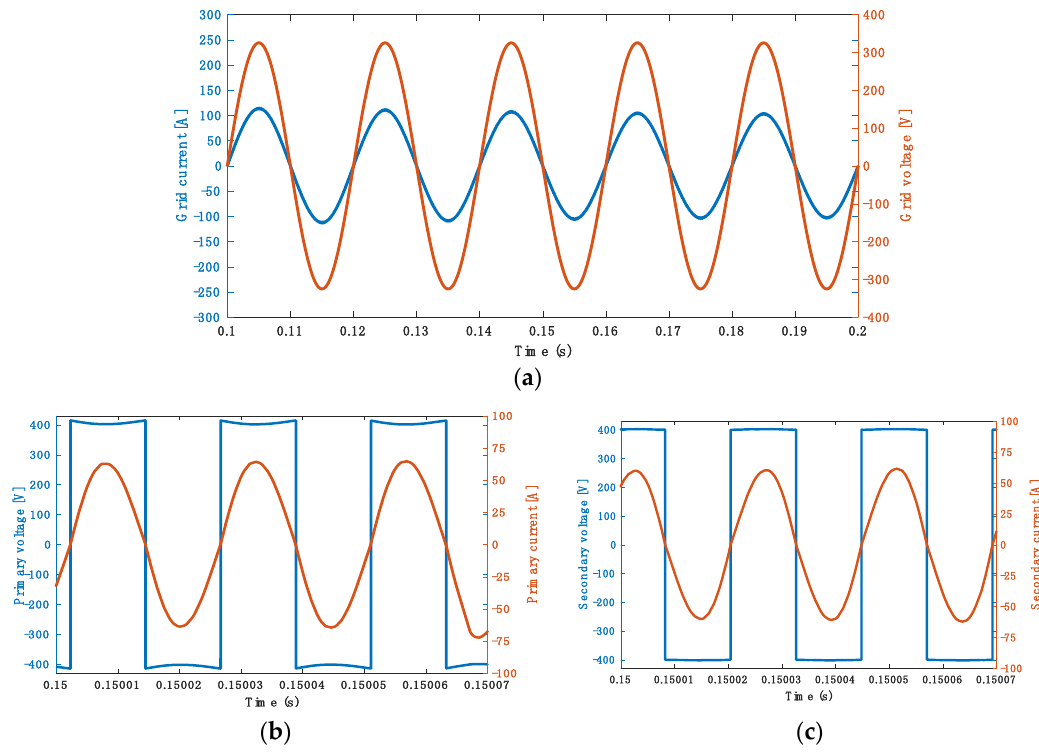
Figure 17. G2V: ( a ) Grid voltage and current; ( b ) Primary resonant voltage and current; ( c ) Secondary resonant voltage and current.